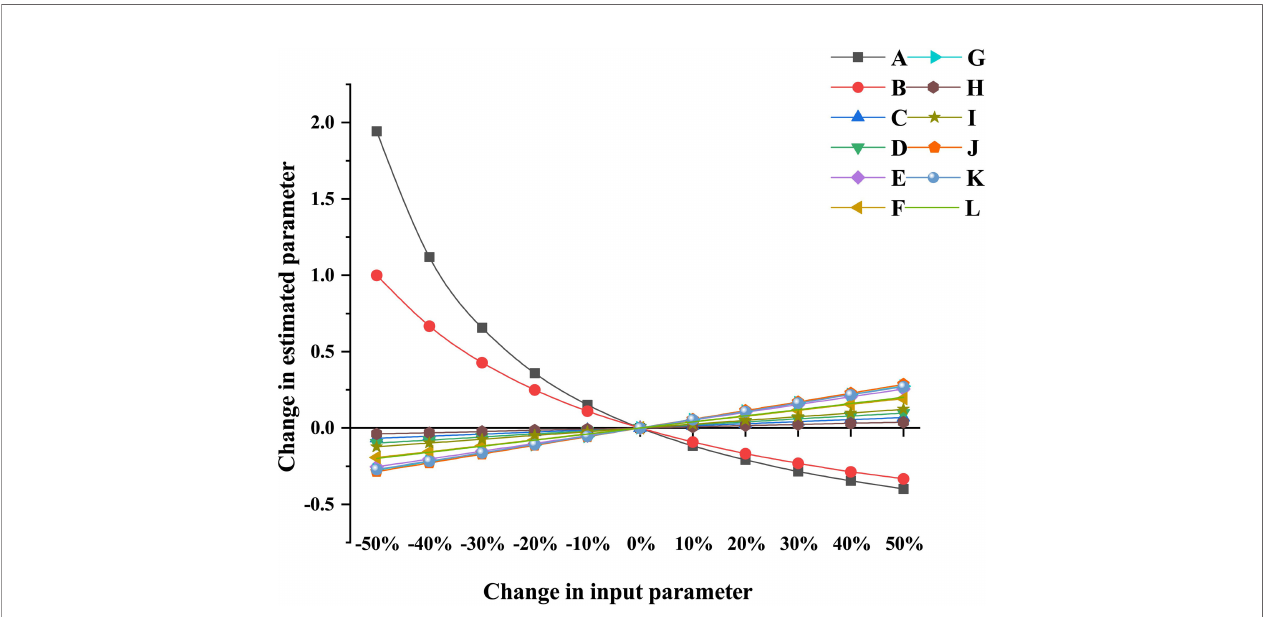
FIGURE 2 | Partial sensitivity analysis of Ecopath model for arti fi cial reef and natural reef ecosystems. (A) Effects of Gastropoda (P/B) on Gastropoda (B) of Ecopath model for arti fi cial reef and natural reef ecosystems. (B) Effects of Infauna (EE) on Infauna (B) of Ecopath model for arti fi cial reef and natural reef ecosystems. (C) Effects of Charybdis japonica (B) on Infauna (B) of Ecopath model for arti fi cial reef ecosystem. (D) Effects of Gobiidae (B) on Infauna (B) of Ecopath model for arti fi cial reef ecosystem. (E) Effects of Crustacean (B) on Infauna (B) of Ecopath model for arti fi cial reef ecosystem. (F) Effects of Crustacean (B) on Gastropoda (B) of Ecopath model for arti fi cial reef ecosystem. (G) Effects of C. japonica (B) on Gastropoda (B) of Ecopath model for arti fi cial reef ecosystem. (H) Effects of C . japonica (B) on Infauna (B) of Ecopath model for natural reef ecosystem. (I) Effects of Gobiidae (B) on Infauna (B) of Ecopath model for Natural Reef ecosystem. (J) Effects of Crustacean (B) on Infauna (B) of Ecopath model for Natural Reef ecosystem. (K) Effects of Crustacean (B) on Gastropoda (B) of Ecopath model for natural reef ecosystem. (L) Effects of C . japonica (B) on Gastropoda (B) of Ecopath model for natural reef ecosystem.